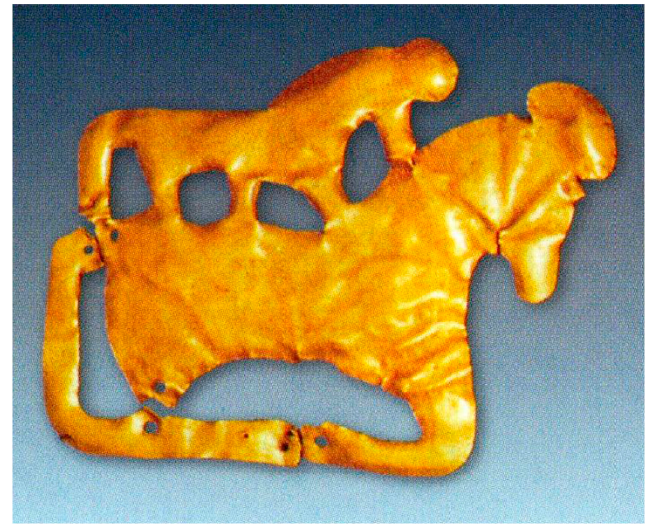
Figure 10. Plaque of a crouching horse topped by a smaller creature, gold, 7.1 × 5.3, excavated from Sandaowan Cemetery, Inner Mongolia; after (Wei 2004), plate 4.1.